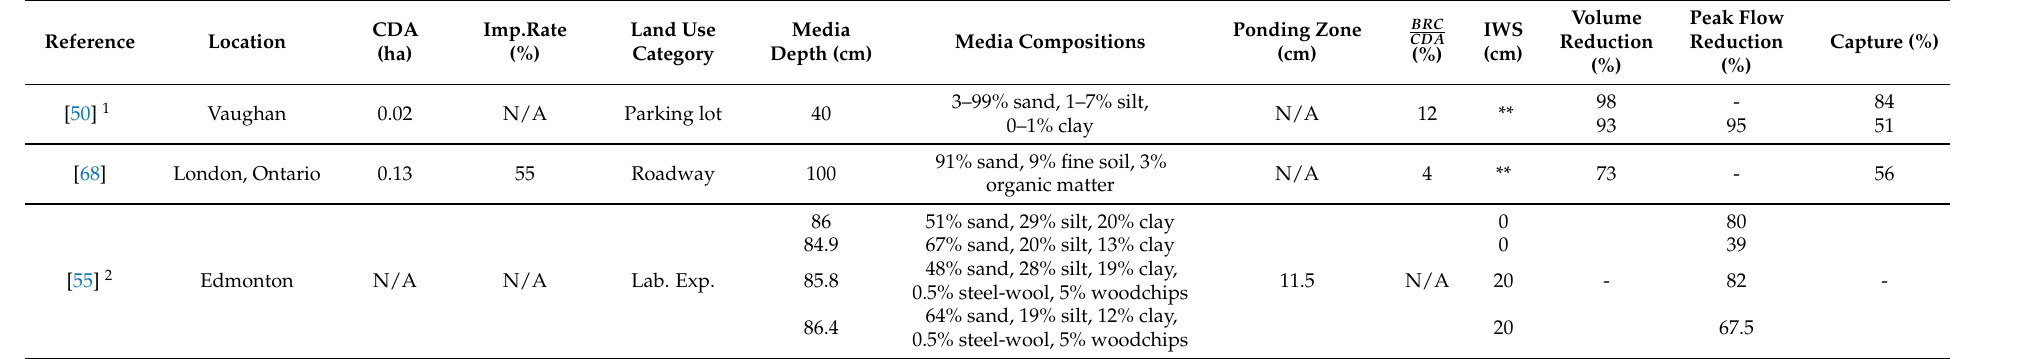
Table 3. The hydrologic performance, volume reduction, peak flow reduction, and capture of the BRC literature studies in Canada. For each study, the site characteristics, including location, contribution drainage area (CDA), imperviousness rate (Imp. Rate), and land use category, are reported together with the system characteristics, including media depth and composition, ponding zone, fraction between the BRC and contribution drainage areas (BRC/CDA) and the internal water storage